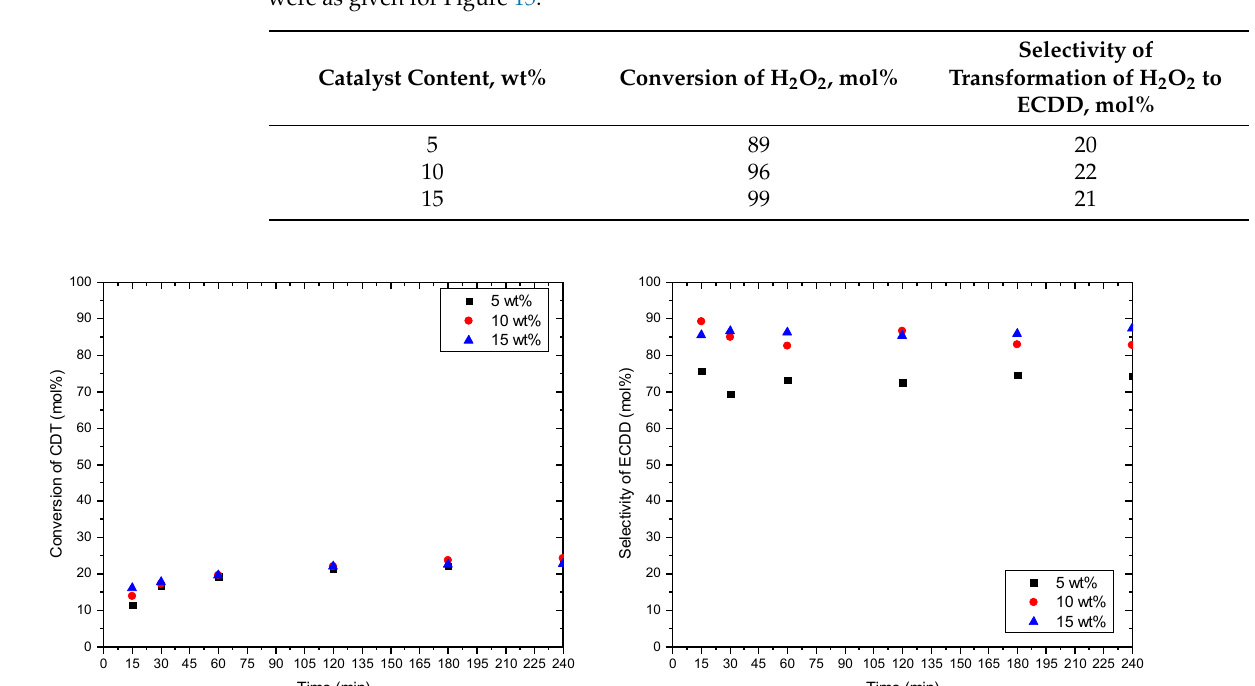
Figure 15. Conversion of CDT and selectivity of transformation of CDT to ECDD as a function of time for reactions conducted with different catalyst contents. Reaction conditions: i-PrOH solvent, 80 wt%; CDT:H 2 O 2 molar ratio, 1:1; temperature, 80 °C; mixing speed, 500 rpm. Table 5. Values of the conversion of H 2 O 2 and selectivity of transformation of H 2 O 2 to ECDD ob- tained after 4 h of performing the reaction with different catalyst contents. Reaction conditions were as given for Figure 15.